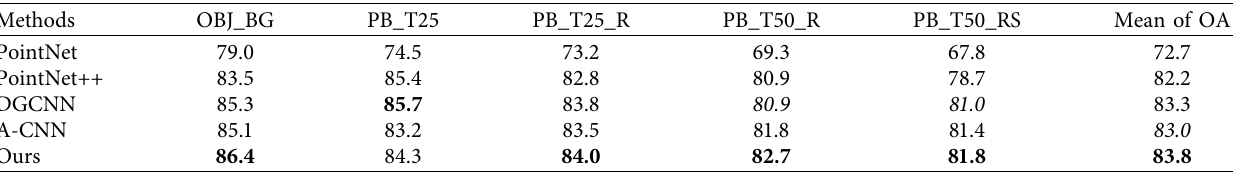
Table 4: Overall accuracy in % on ScanObjectNN. (The top three accuracies are highlighted by bold, underline, and italic.)